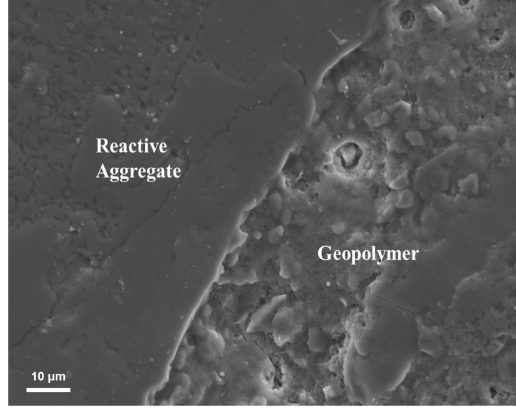
Figure 4. Typical SE image of aggregate-matrix interface of the fly ash geopolymer concrete prism specimens after 1-year